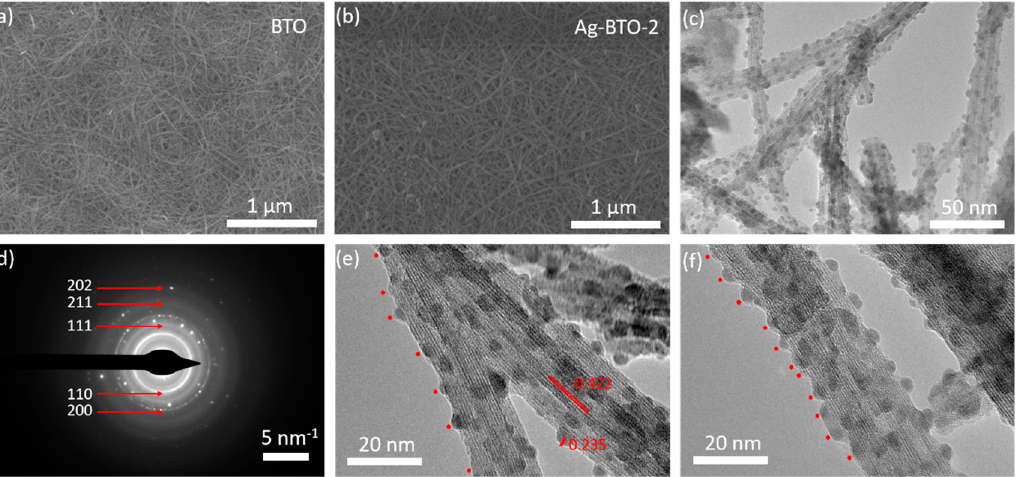
Figure 1. The characterizations of the samples. ( a,b ) SEM images of BTO and Ag-BTO nanofibers. ( c ) TEM image of Ag-BTO nanofibers. ( d ) SAED pattern of Ag-BTO nanofibers. ( e,f ) HRTEM images of Ag-BTO-1 and Ag-BTO-2.